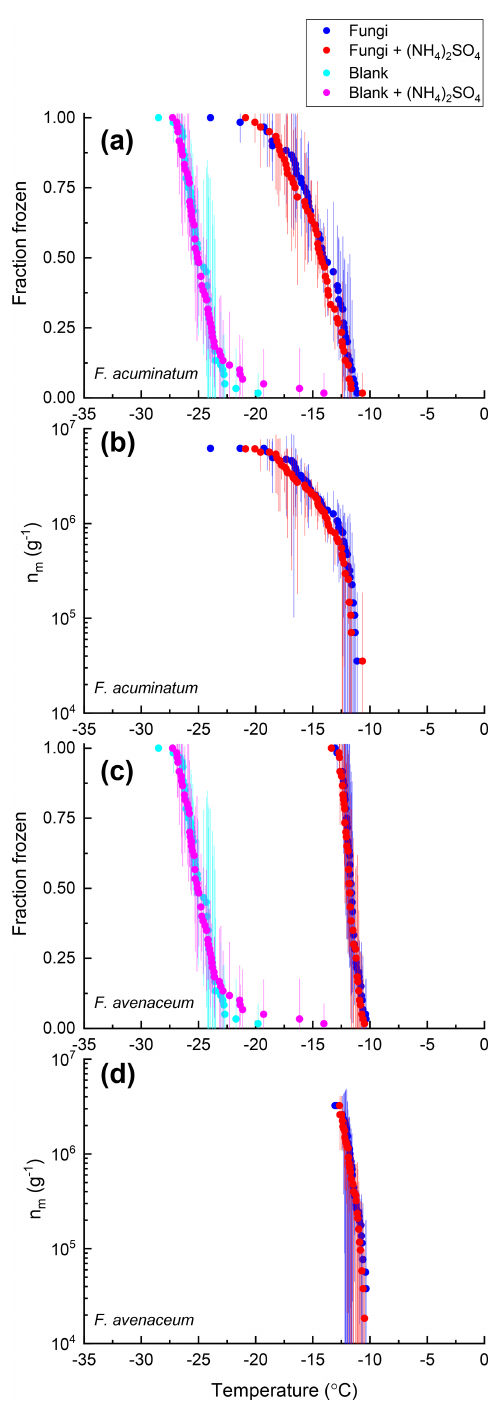
Figure 4. Fraction of droplets frozen (a, c) and ice nucleation active site densities n m (T ) (b, d) for samples of F. acuminatum (a, b) and F. avenaceum (c, d) with (red) and without (blue) 0.05M(NH 4 ) 2 SO 4 compared with the respective growth medium with (pink) and without (cyan) 0.05M(NH 4 ) 2 SO 4 . Freezing data (both samples and blanks) have been corrected for freezing point depression by 0.05M(NH 4 ) 2 SO 4 . Error bars represent the 95% confidence interval of fraction frozen or n m (T ) at temperature T calculated using Student’s t